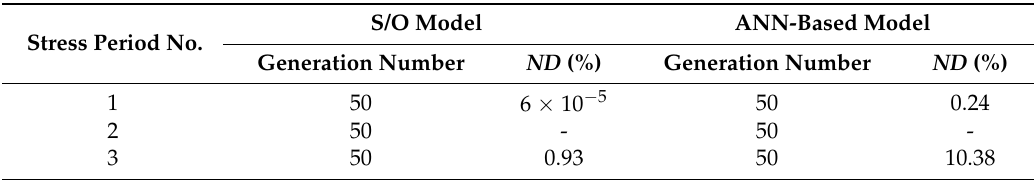
Table 11. Comparison of identification errors using the proposed S/O model and the artificial neural network (ANN)-based